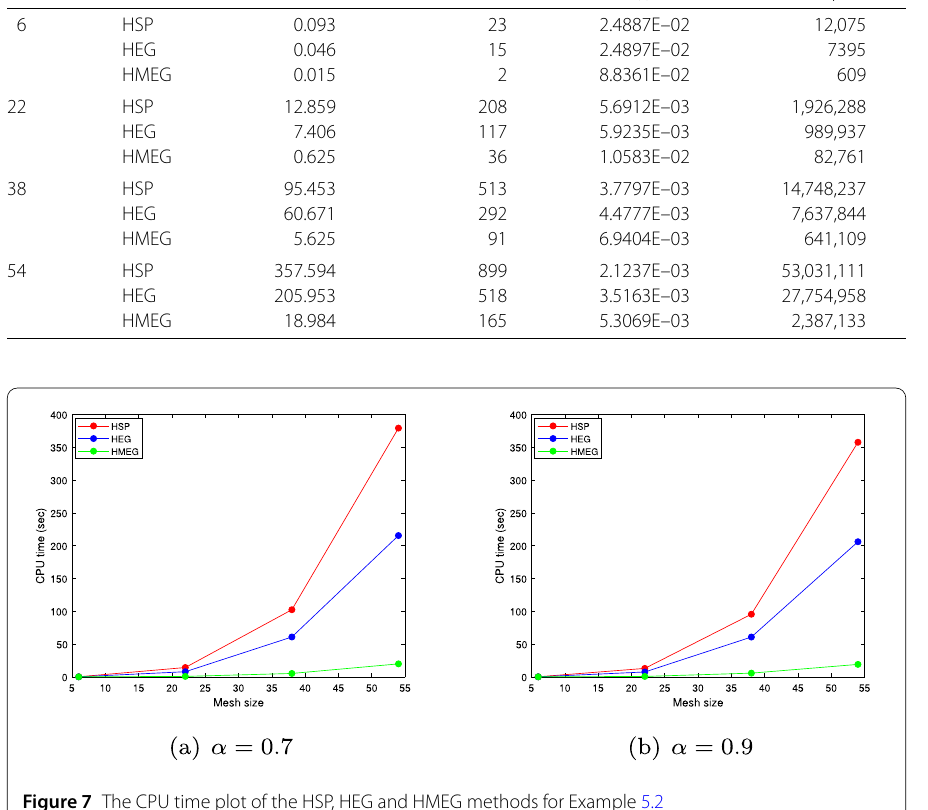
Table 5 The numerical results of the HSP, HEG and HMEG methods at α = 0.9 for Example 5.2 h –1